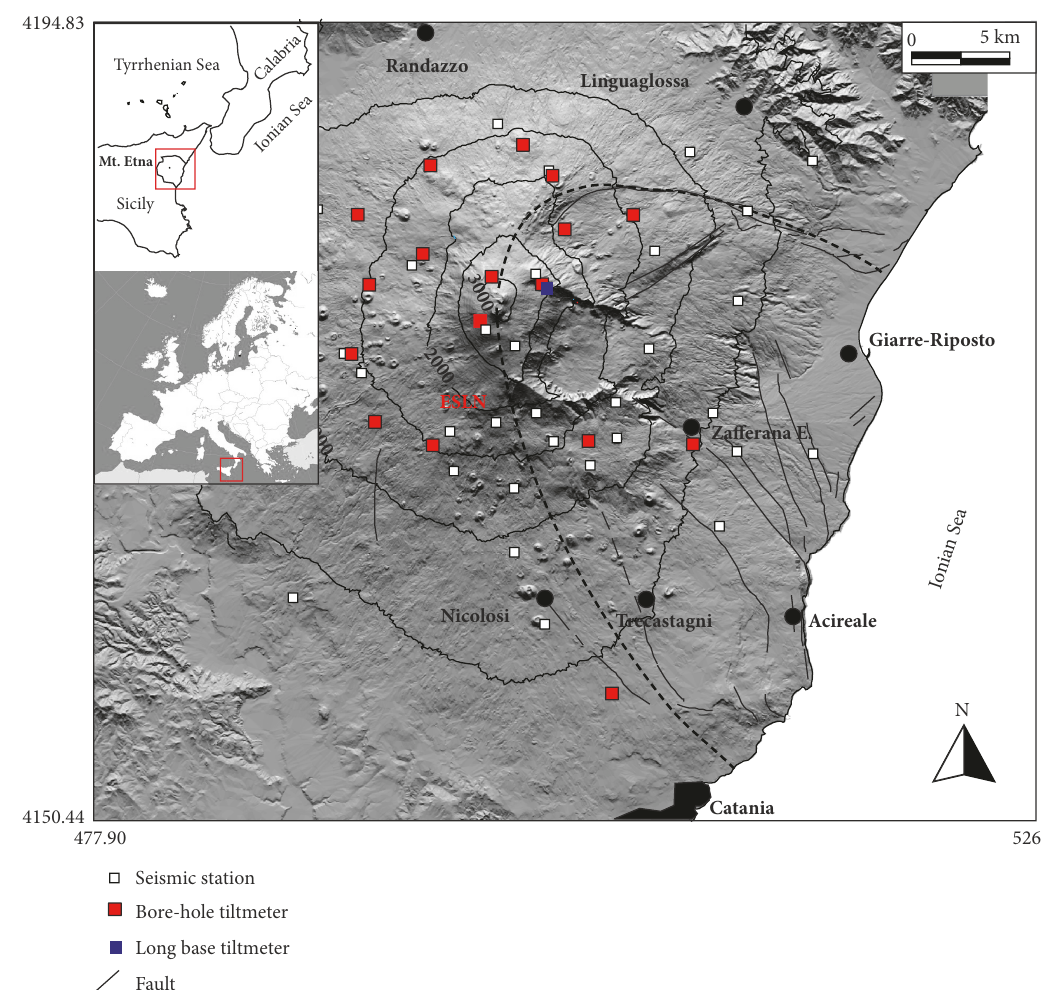
Figure 1: Map of the permanent tilt and seismic networks operating on Mt.